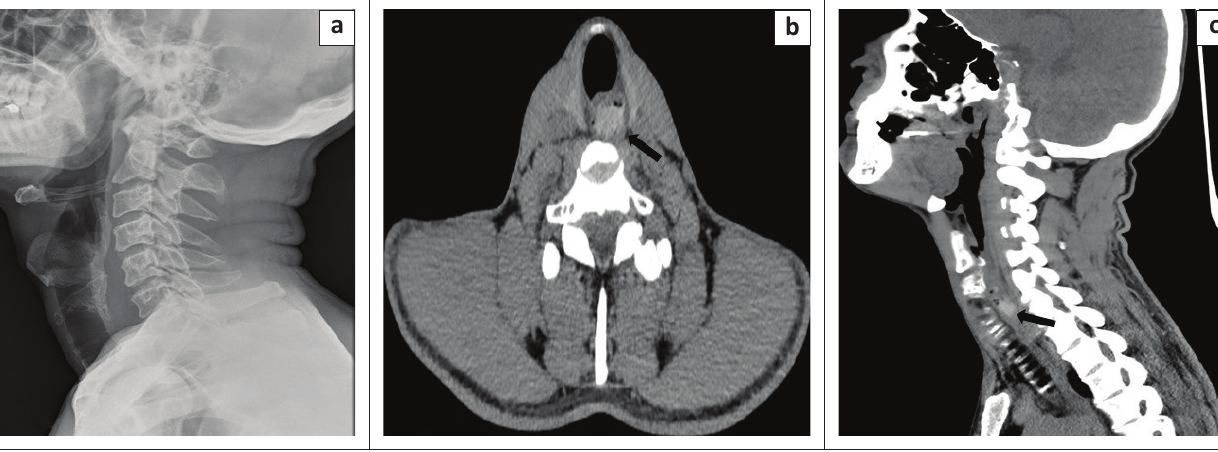
FIGURE 7: Food bolus (meat) impaction in a 70-year-old male. (a) Lateral radiograph of the neck was unremarkable. Computed tomography (b) axial and (c) sagittal reformatted images shows the impacted bolus of food (black arrow) in the hypopharynx at the C6–C7